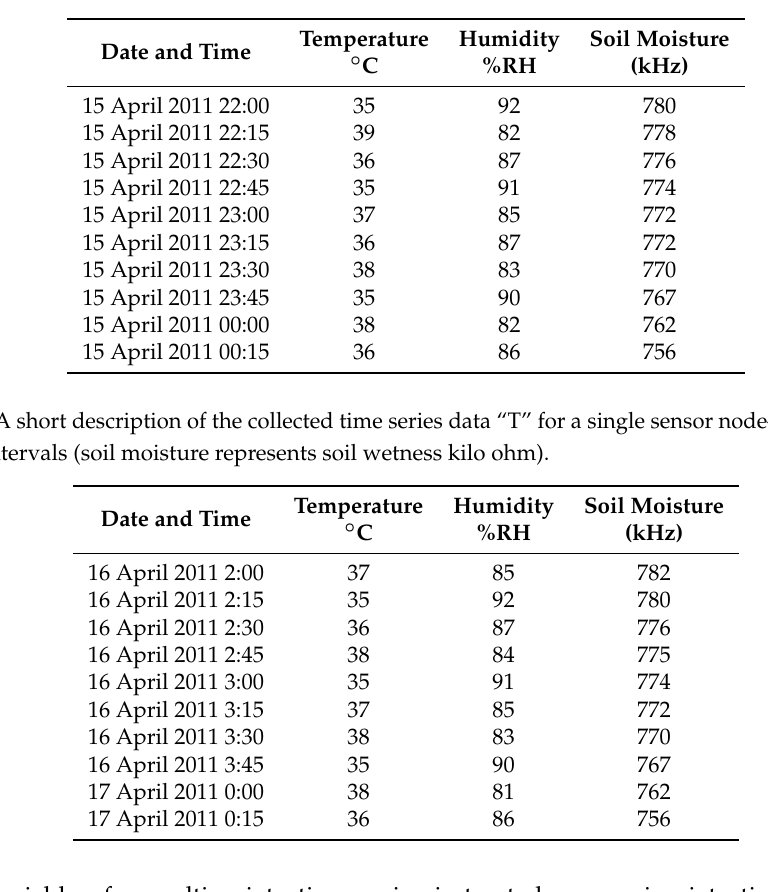
Table 1. A short description of the collected time series data “S” for a single sensor node—measured at 15 min intervals (soil moisture represents soil wetness kilo ohm).